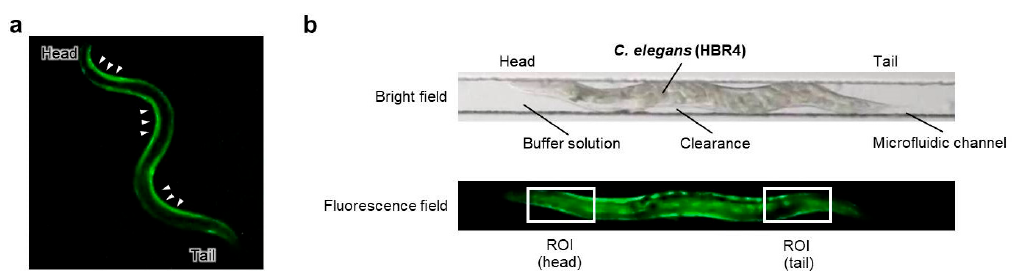
Figure 3. Schematic of the fluorescent imaging of body-wall muscles for C. elegans crawling ( HBR4 strain). ( a ) Muscle contraction pattern of body-wall muscle cells during forward motion (crawling). High fluorescence (Ca 2+ ) indicates the contraction of body-wall muscle cells (indicated by white triangles). ( b ) Schematic of on-chip observations of an individual C. elegans in a straight microfluidic channel of a Worm Sheet. The upper panel is a bright-field image of the microfluidic channel enclosing an individual active C. elegans , while the bottom panel is a corresponding fluorescence field image. The small degree of clearance between the body of an individual C. elegans and the straight microfluidic channel makes it possible for the animal to bend, such that muscle contraction and extension during crawling can be observed. To evaluate the luminance of Ca 2+ , a ROI in the head and tail area was set as a box 120 µm wide and 60 µm high.